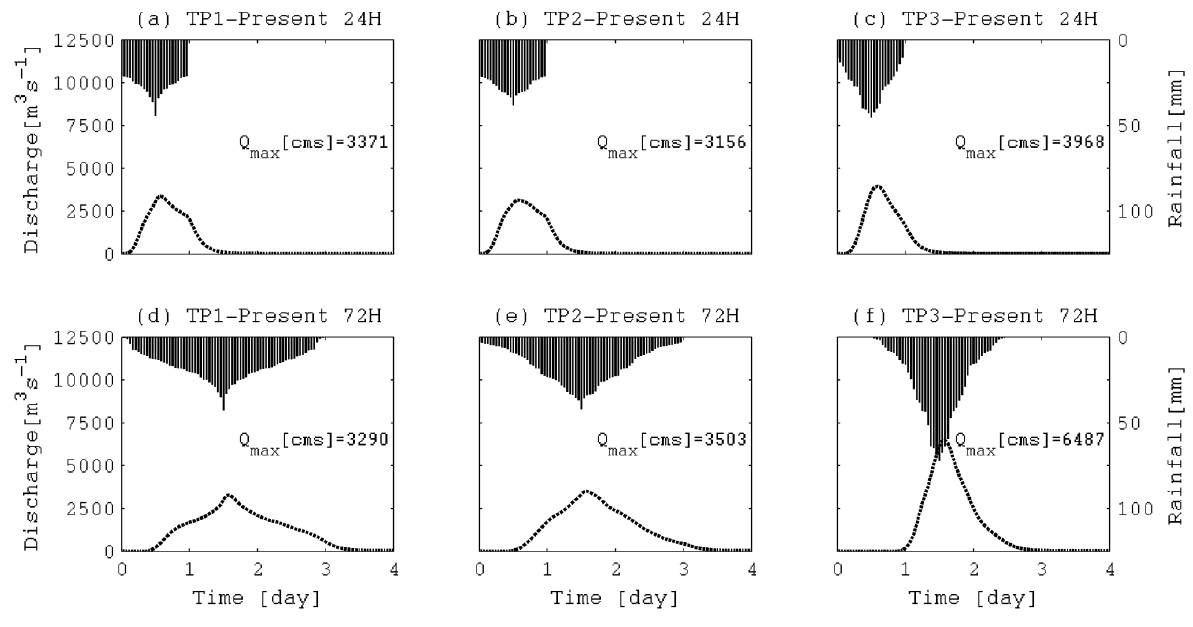
Figure 6. TP 1 to TP 3 rainfalls and discharges, ( a , b , c ) for 24-h and ( d , e , f ) for 72-h